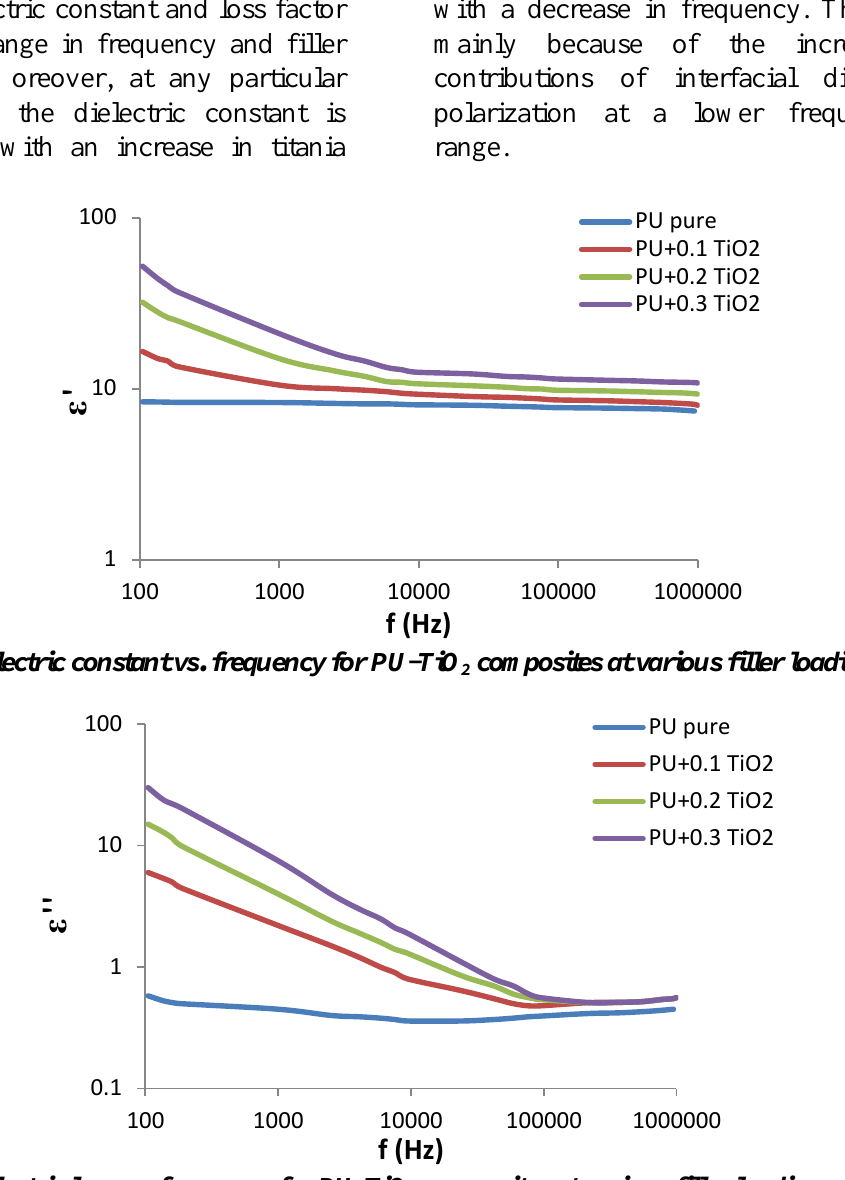
composites at various filler 2